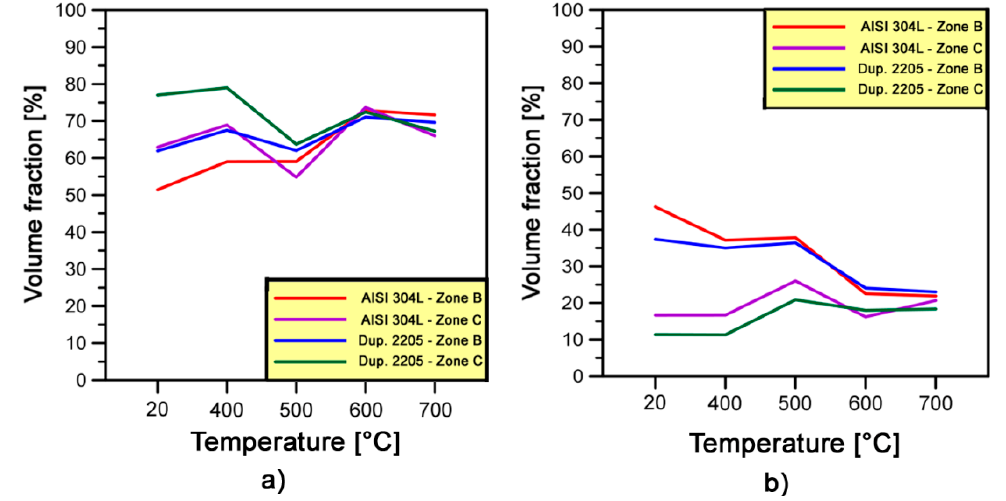
Figure 15. Fractions of: ( a ) LABs; and ( b ) HABs estimated in both stainless steels at different forging temperatures.